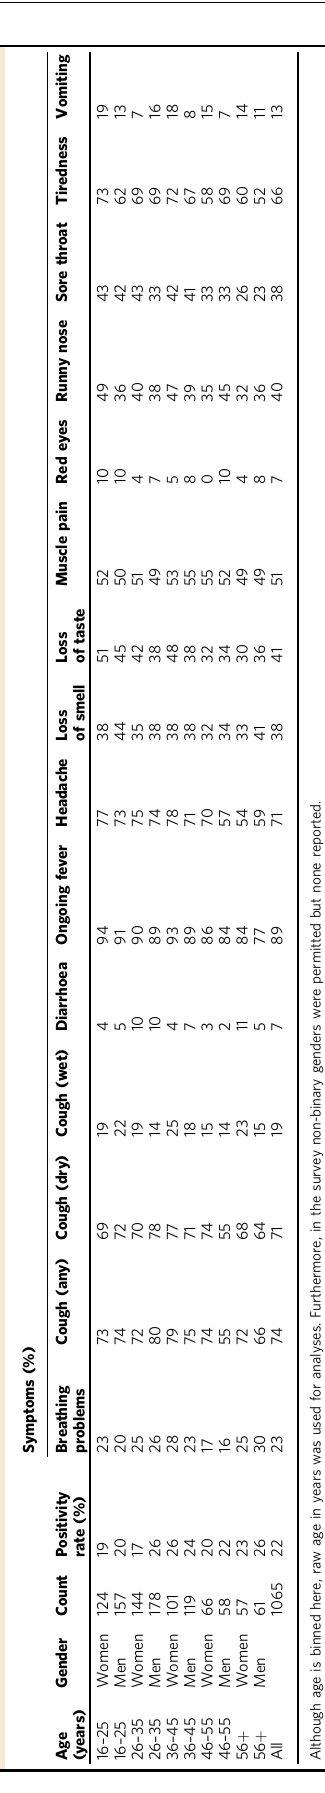
ling: model selection) for both the multivariate probit syndromic data only model and the thresholded multivariate probit syn- dromic data with rapid antigen test result (hereafter the Syndromic-only and Syndromic-RAT combined) models showed a marked decline in predictive power at more than four symp- toms. The fi nal four symptoms retained in Syndromic-only were loss of smell, ongoing fever, diarrhoea and loss of taste and in Syndromic-RAT combined were ongoing fever, wet cough, loss of smell and dry cough. The symptoms are listed in reverse order of importance as determined by model selection (i.e., all four symptoms were retained in the four symptom model, the fi rst was removed in the three symptom model, the second was also removed in the two symptom model) and the median estimated correlations can be seen in the Supplementary Results (Supple- mentary Figures 1 and 2). The covariate gender was dropped for both model classes while age was dropped in the Syndromic-RAT combined class but retained in the Syndromic-only class.